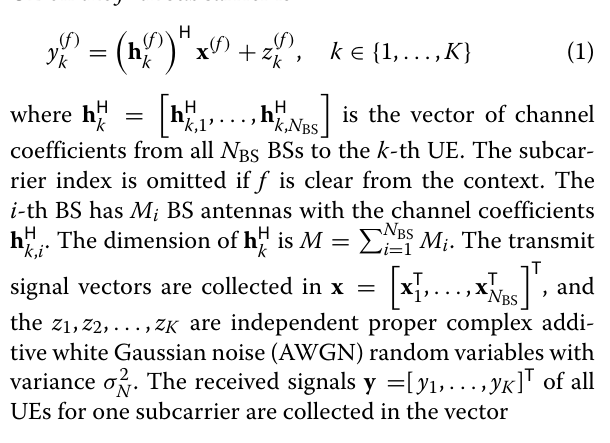
broadcast channel (BC). The received signal of the k